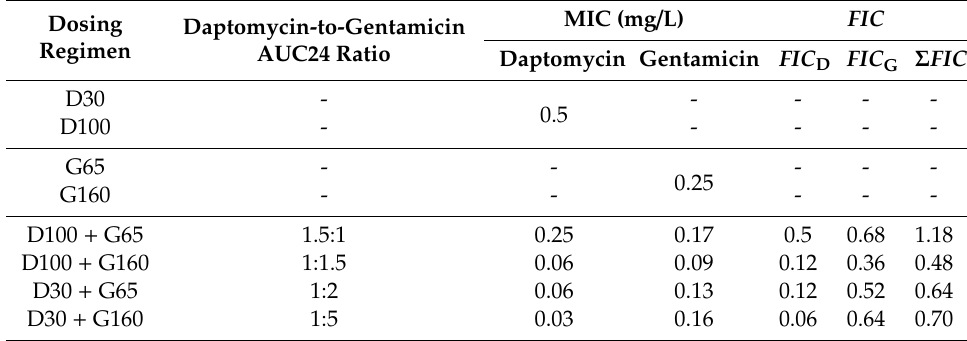
Table 1. MICs of daptomycin and gentamicin alone or in combination against Staphylococcus aureus 293 and respective FIC